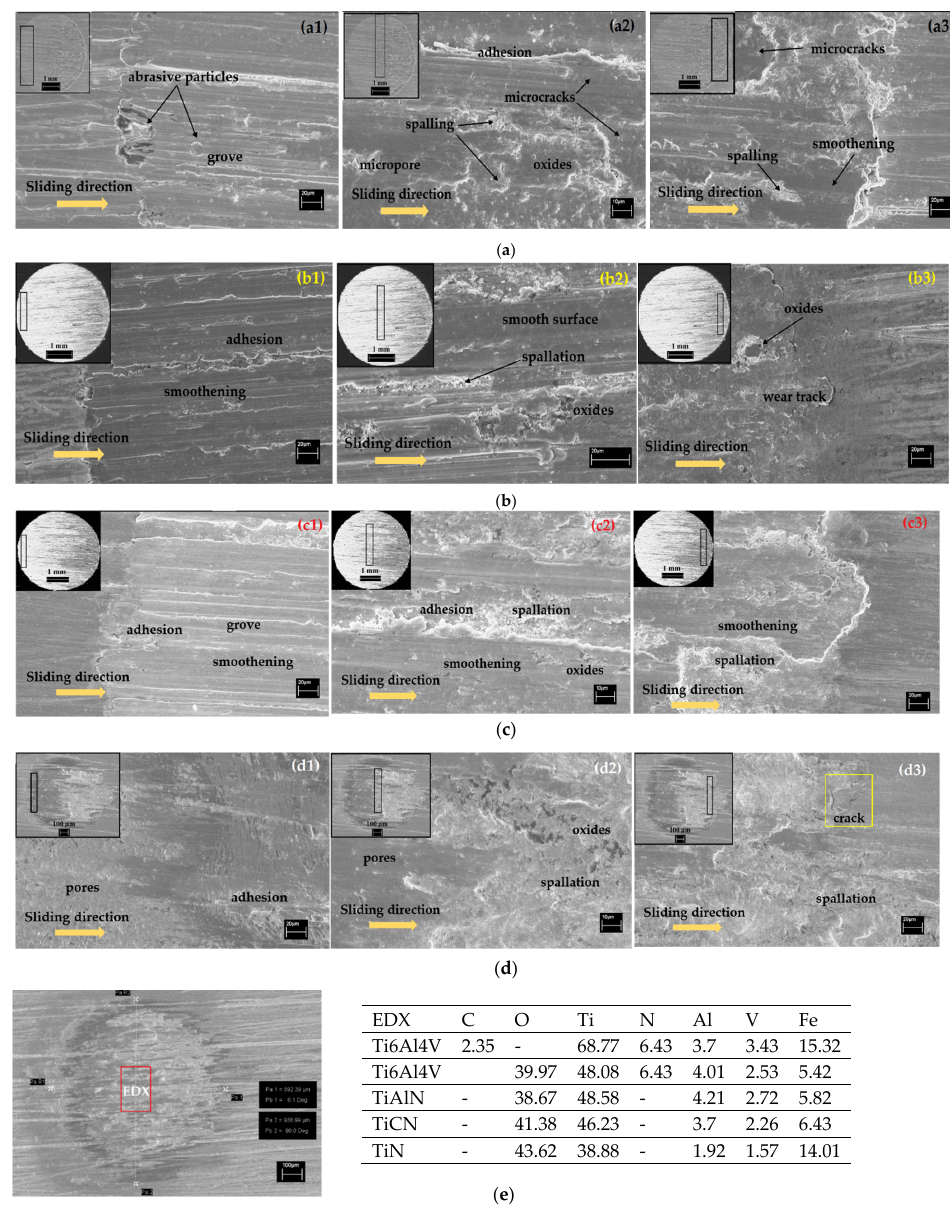
Figure 17. The wear track SEM images of ( a ) Uncoated Ti6Al4V, ( b )TiAlN, ( c ) TiCN, ( d ) TiN, ( a1 – d1 ) The beginning of wear track, ( a2 – d2 ) Medium zone, ( a3 – d3 ) The end of the wear track, ( e ) EDX analysis of the medium zone.